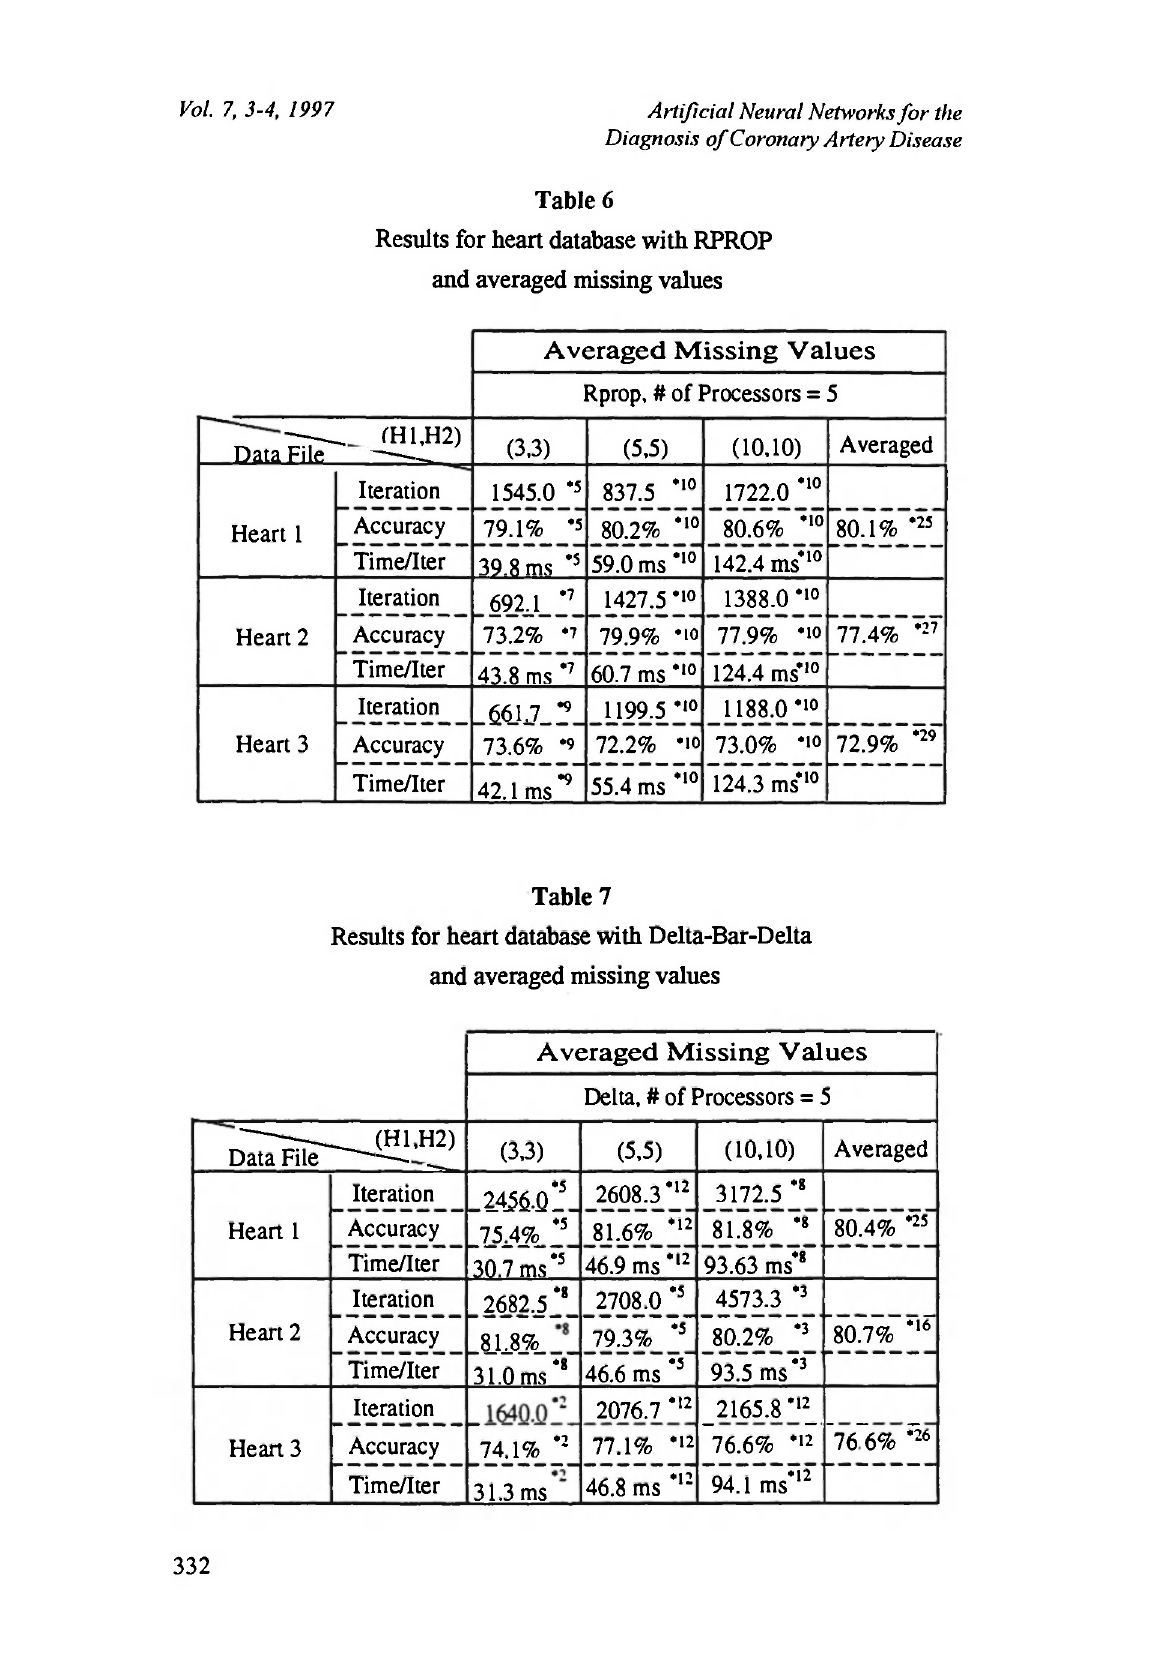
Results for heart database with Delta-Bar-Delta and averaged missing